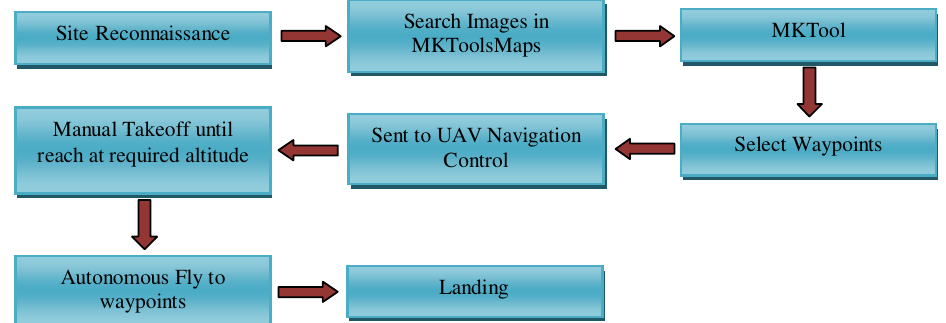
Figure 3. General Step for Data Acquisition Using Hexacopter UAV